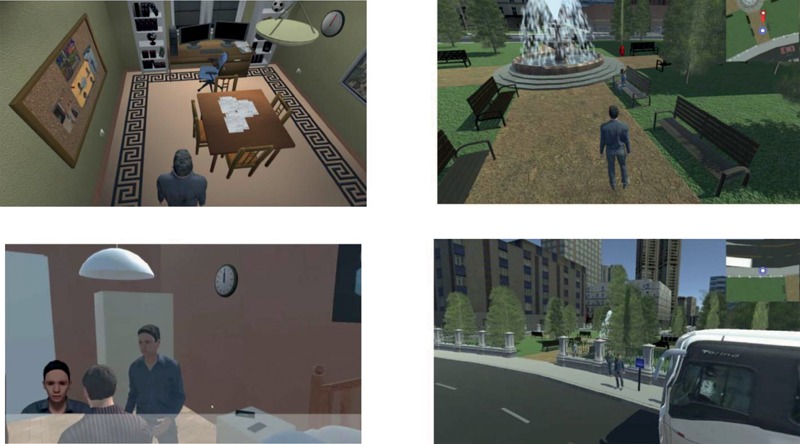
Stigma-Stop scenes.